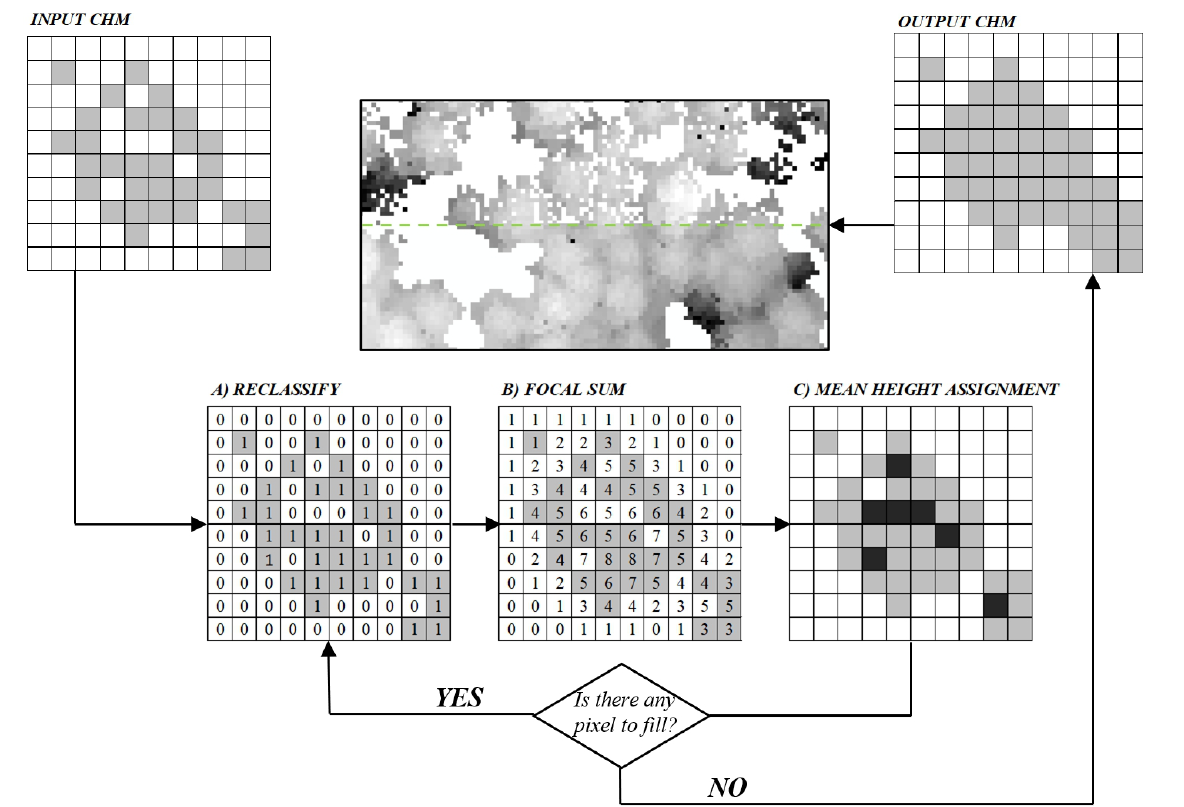
Figure 5. Scheme of the iterative method of Canopy Height Model (CHM) interpolation on the basis of pixel neighborhood analysis together with an example of the algorithm operation on a fragment of the CHM with a pixel size of 0.40 m (white—empty cells, light gray—non-empty cells with height, dark gray—interpolated